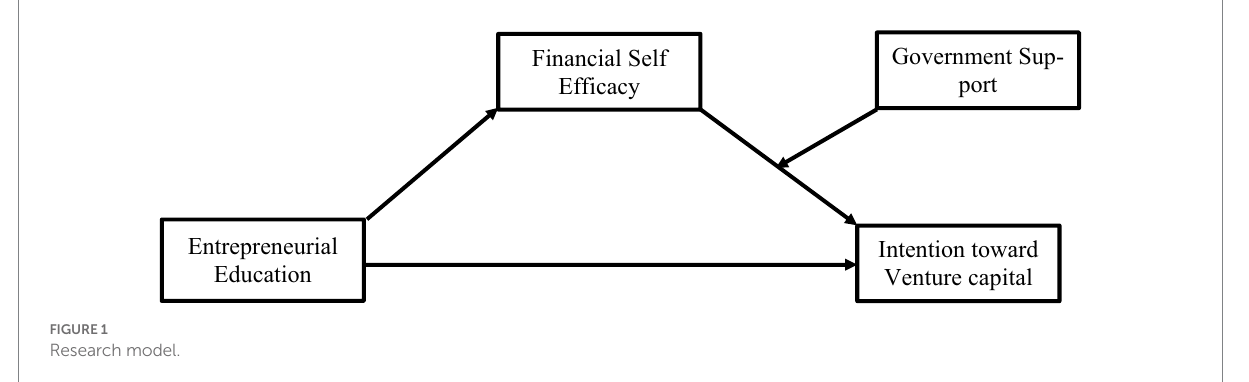
FIGURE 1 Research